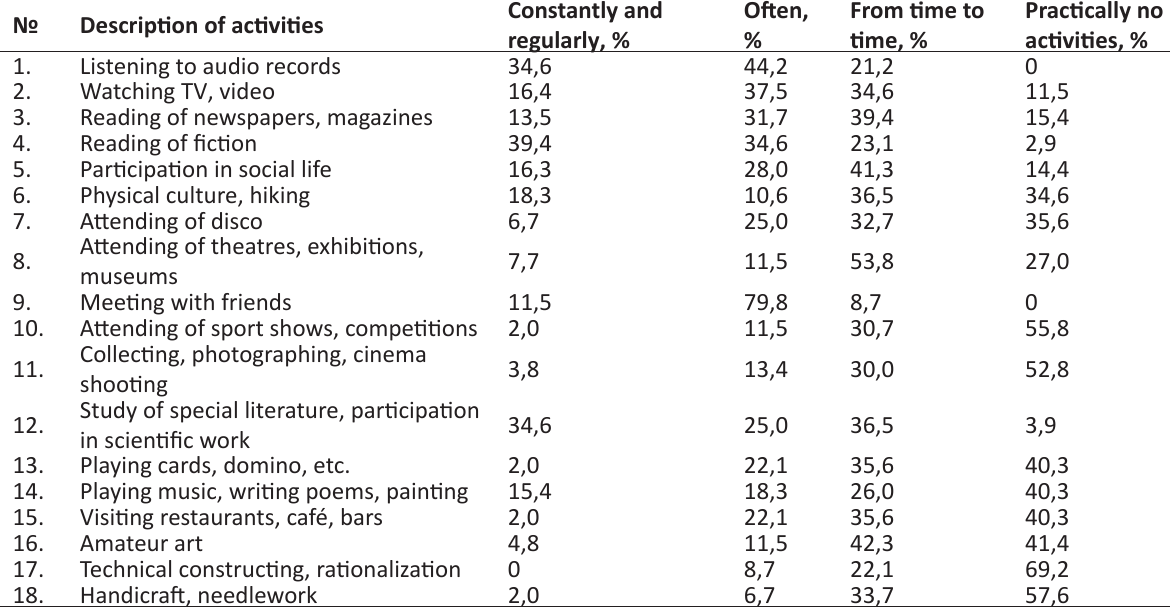
Handicraft, needlework Table 2. Day regime of SHG girl students of pedagogic HEE № Questions